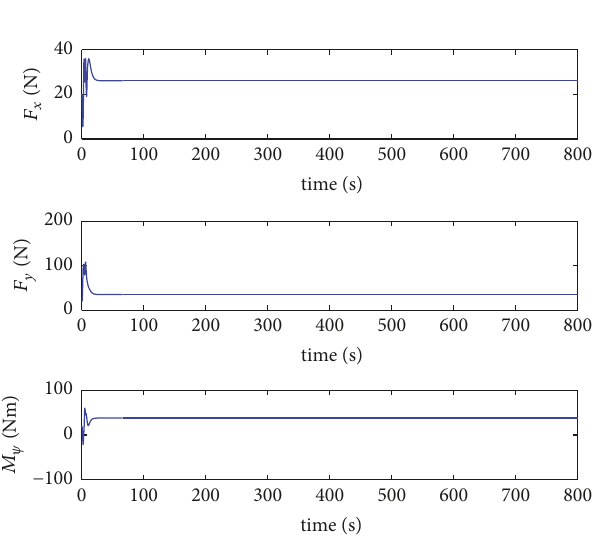
Figure 2: Path tracking errors.